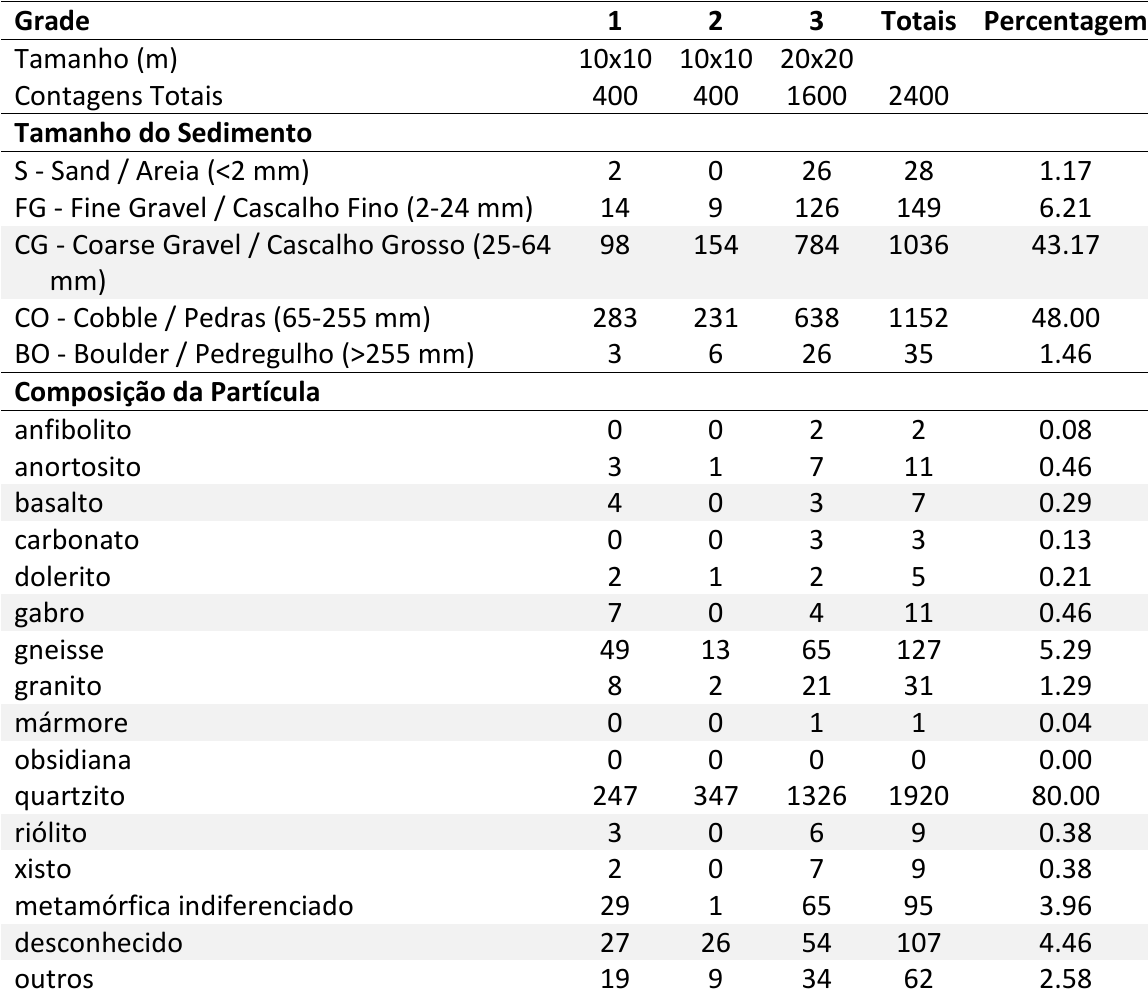
Table 2. Results of pebble counts and clast